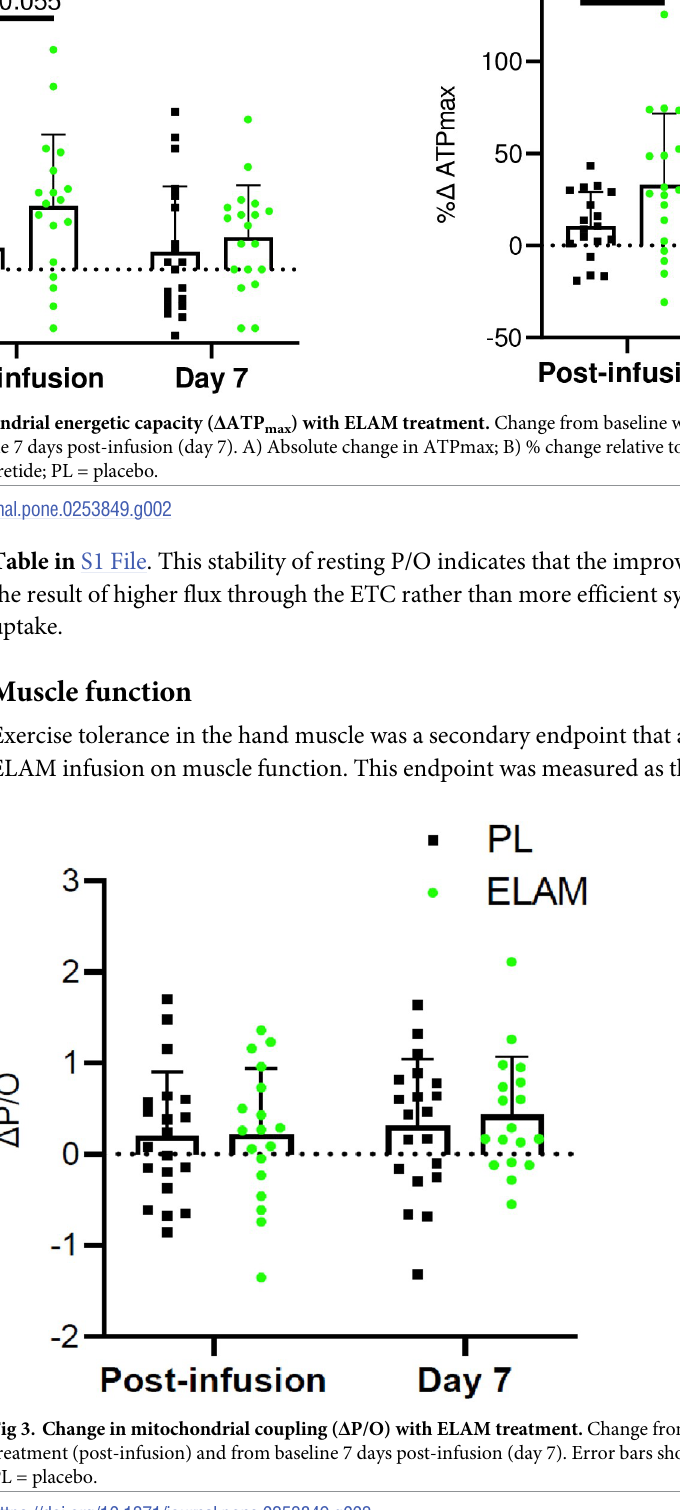
Fig 3. Change in mitochondrial coupling ( Δ P/O) with ELAM treatment. Change from baseline with ELAM treatment (post-infusion) and from baseline 7 days post-infusion (day 7). Error bars show SD. ELAM = elamipretide; PL =